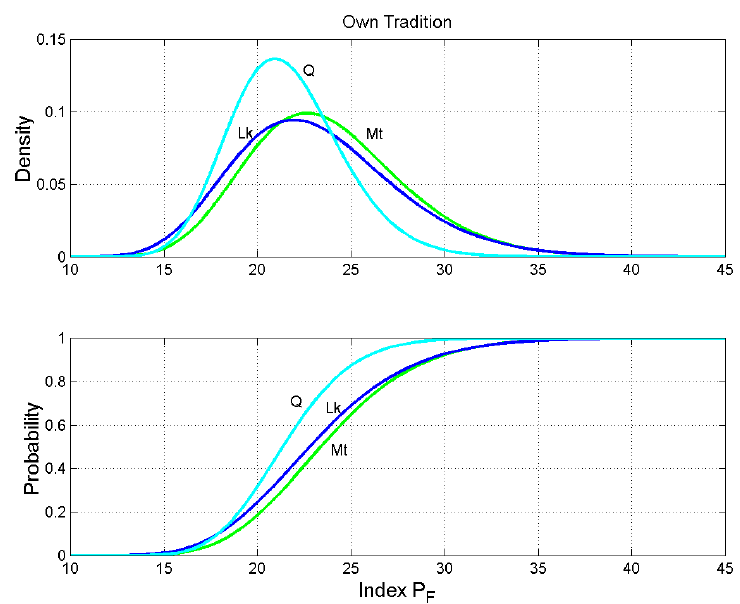
Figure 13. Own Tradition. Probability density functions (upper panel) and probability distribution functions (lower panel) of the number of words per sentence 𝑃 𝐹 . Matthew : green line; Luke : blue line; Q : cyan line.